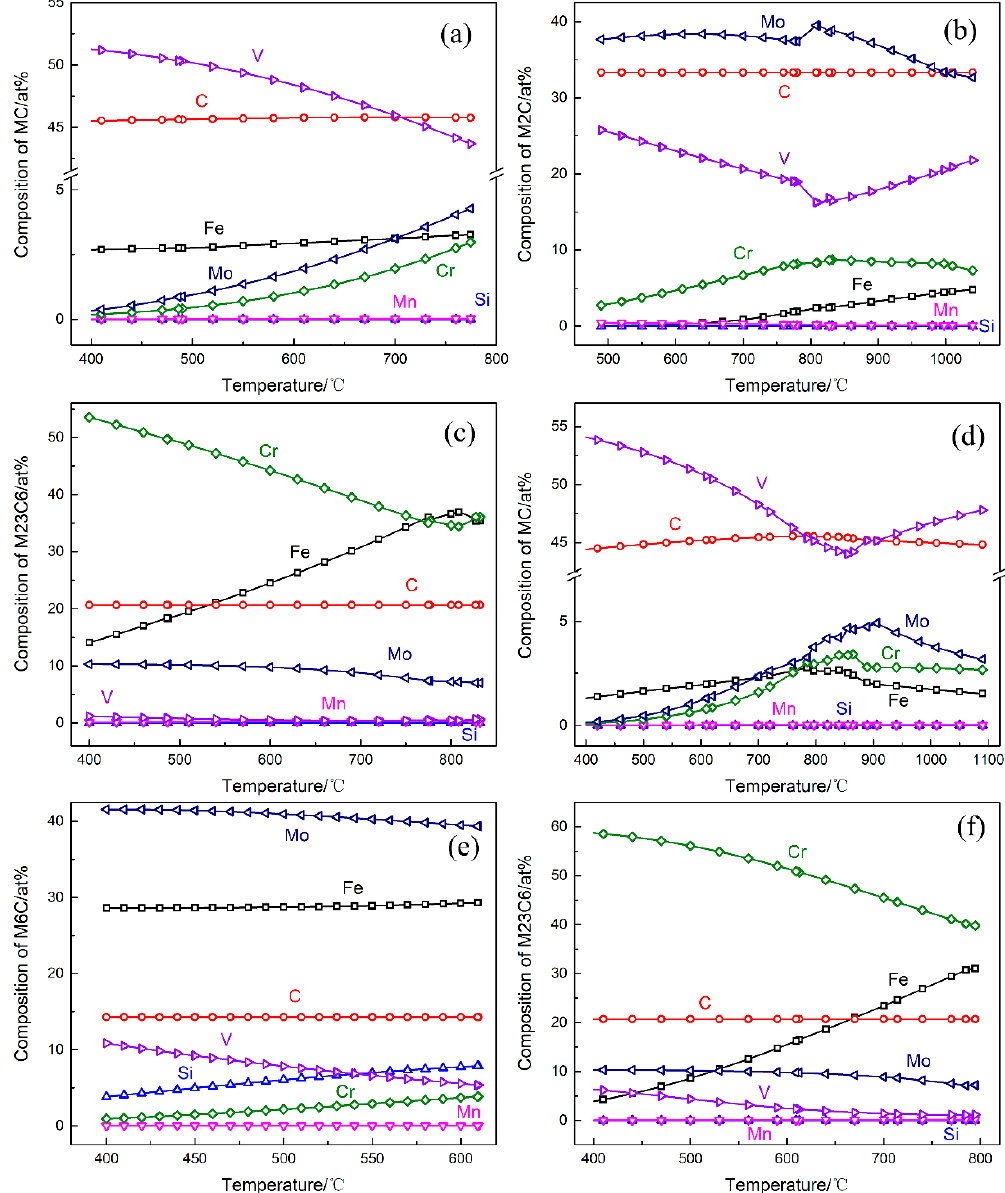
Figure 4. Equilibrium composition of the ( a ) MC, ( b ) M 2 C, and ( c ) M 23 C 6 phases in the 5Cr5Mo2 steel and ( d ) MC, ( e ) M 6 C, ( f ) M 23 C 6 phase in the H13 steel.